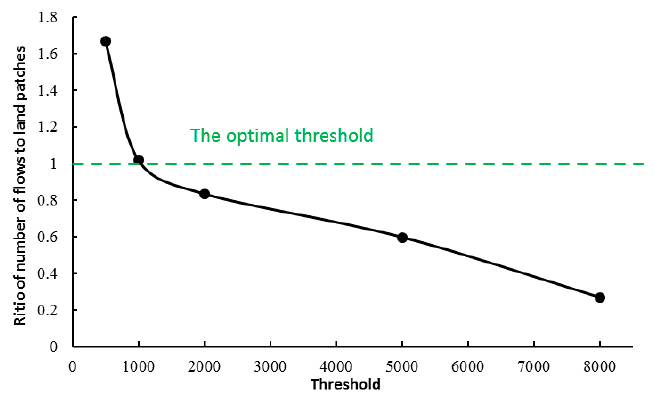
Figure 8. The optimal threshold determination.